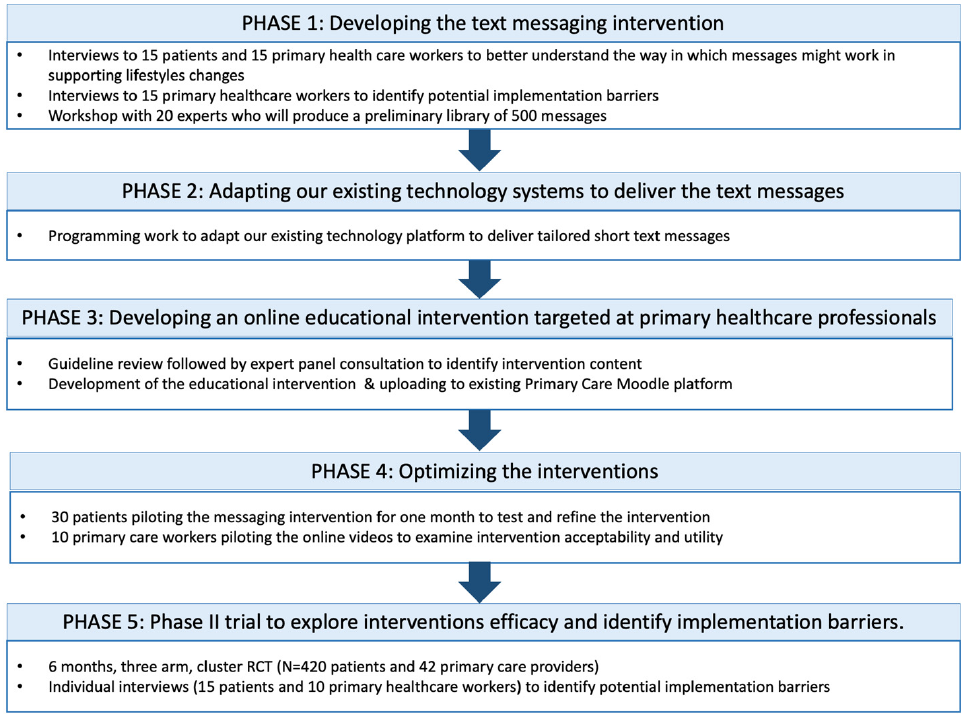
Figure 1. PreDiabeText project overview.